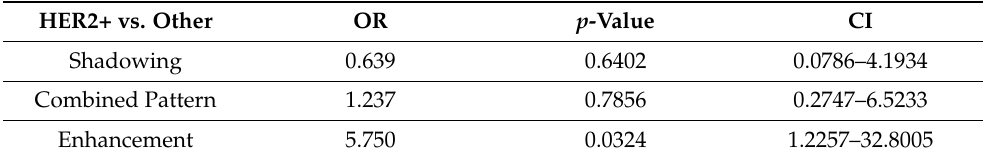
Table 6. Effect of a variable “posterior features” in specific cancer subtypes (HER2+ vs. other cancer subtypes).